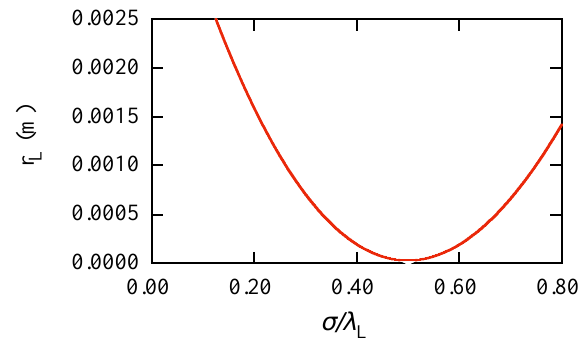
FIG. 10. (Color) The emittance growth plotted against coupling length in short, smooth